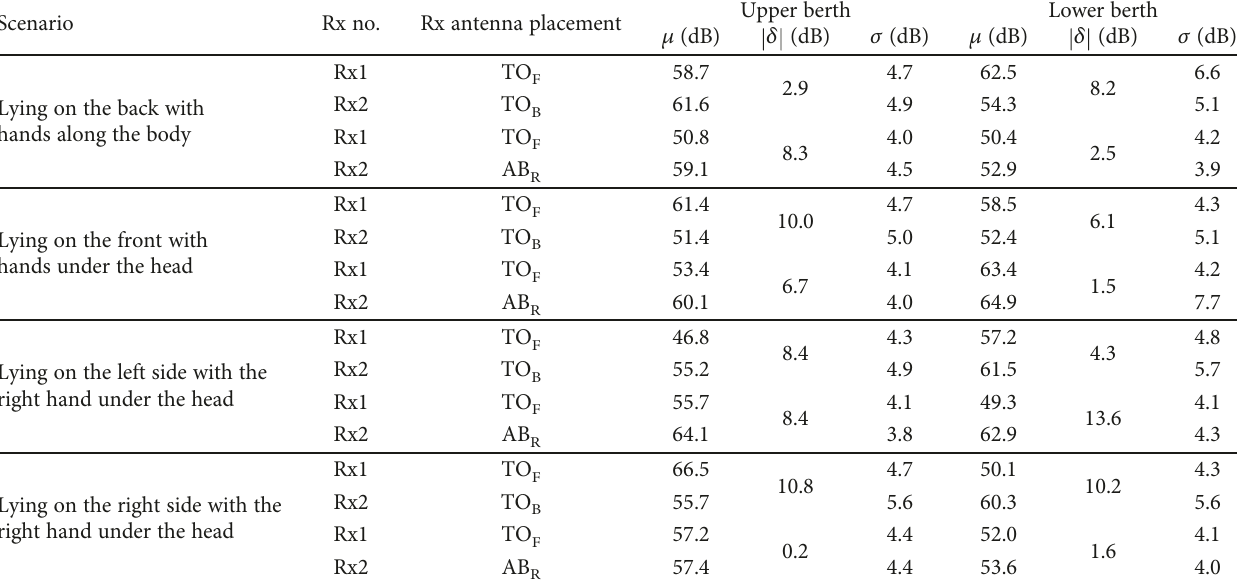
Table 3: The mean ( μ ) and standard deviation ( σ ) of system loss for di ff erent placements of the space diversity Rx antennas for lying scenarios in the ferry environment.